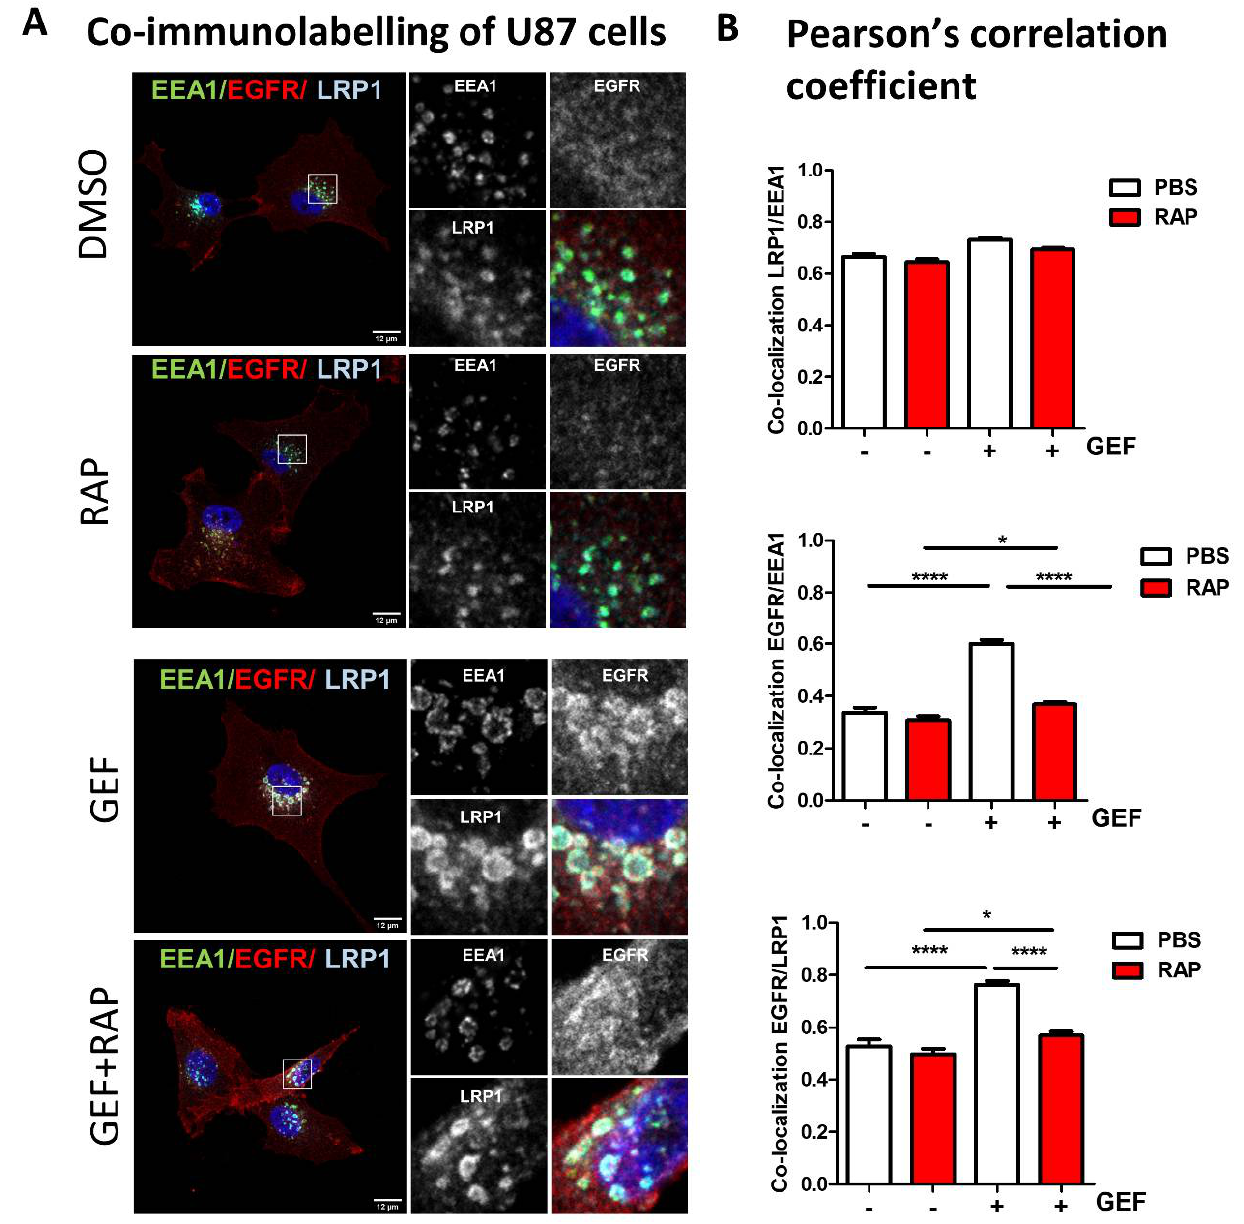
Figure 4. LRP-1 antagonist decreases EGFR/LRP-1 co-localisation into early endosomes. ( A ) U87 cells were seeded on glass coverslips. After 4 h of treatment with gefitinib (20 µ M) and/or of RAP (500 nM), cells were fixed, EEA1 (green), EGFR (red) and LRP-1 (cyan) were immunodetected and analysed by confocal microscopy. Magnified images are from the inserts into the peri-nuclear area, either in single channels or in merged ones. Scale bar = 20 µ m. ( B ) Co-localisation was determined using Pearson’s correlation coefficient from 40–60 cells from 3 independent experiments. Data, reported as column histograms, are the mean +/ − SEM * p < 0.5, **** p < 0.0001.